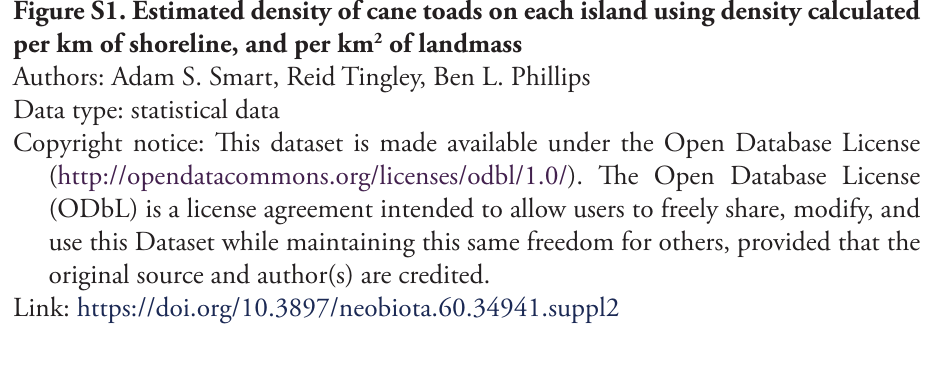
Figure S1. Estimated density of cane toads on each island using density calculated per km of shoreline, and per km 2 of landmass